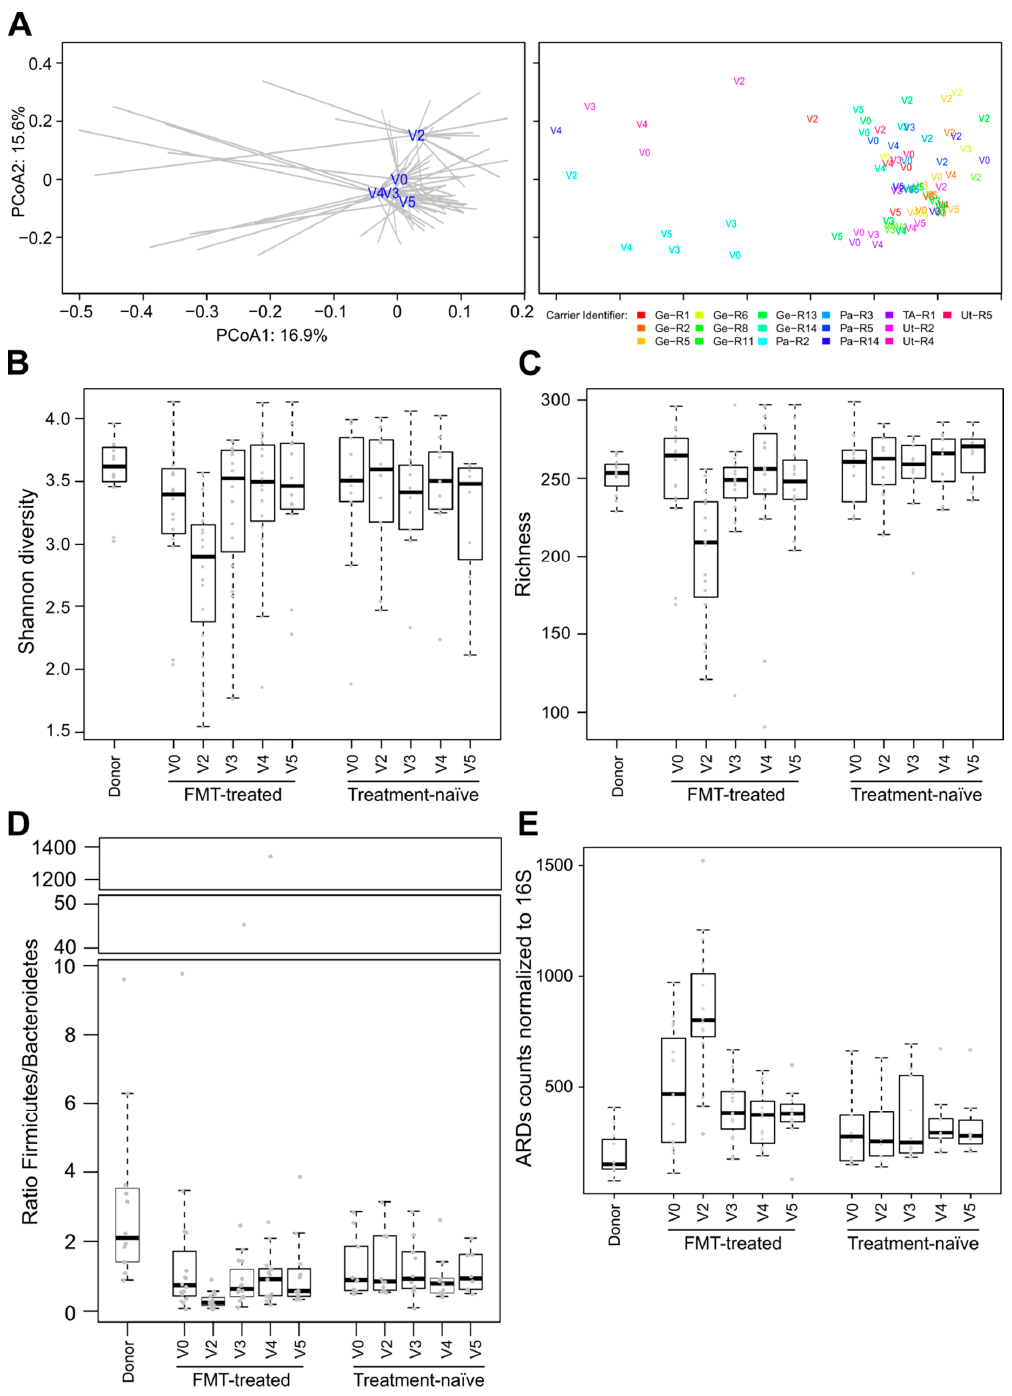
Figure 2. Effect of colistin/neomycin on microbiota composition of FMT-treated carriers. ( A ) PCoA plots of microbiota profiles computed on the species relative abundance of FMT-treated individuals. On the left, centroids (averaged microbiota profiles) from each time point of FMT-treated carriers are represented. Each sample is connected to its corresponding centroid with grey lines. On the right, samples are labeled according to the time point and colored according to the carrier. Shannon diversity ( B ) and species richness ( C ) were computed after rarefying sequencing reads to 40,000. ( D ) Ratio of Firmicutes to Bacteroidetes. ( E ) Number of reads assigned to ARDs and normalized to 1000 16S rRNA gene read